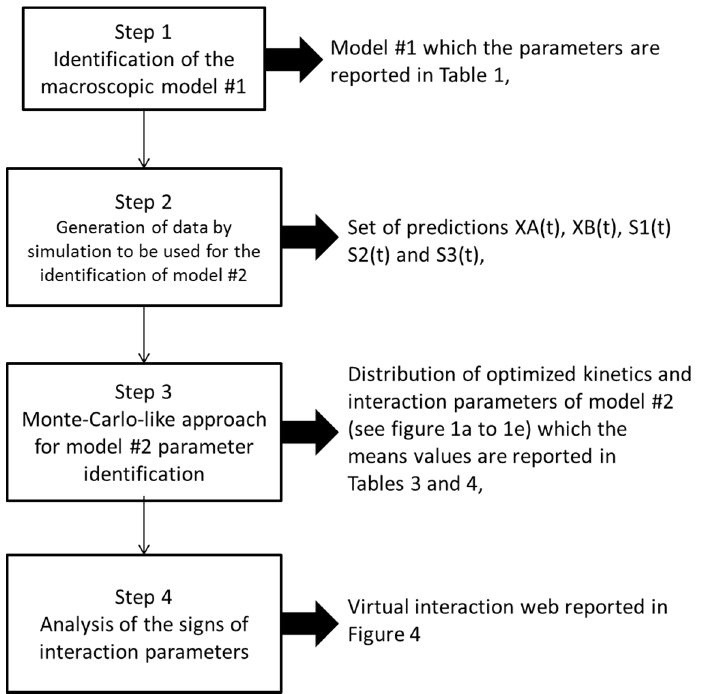
Figure A1. Identification procedure.